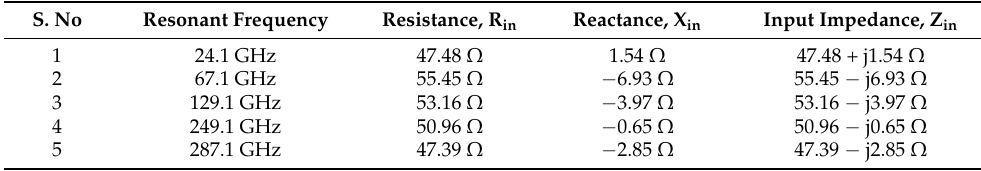
Table 3. Input impedance of proposed antenna at selected resonant frequencies.